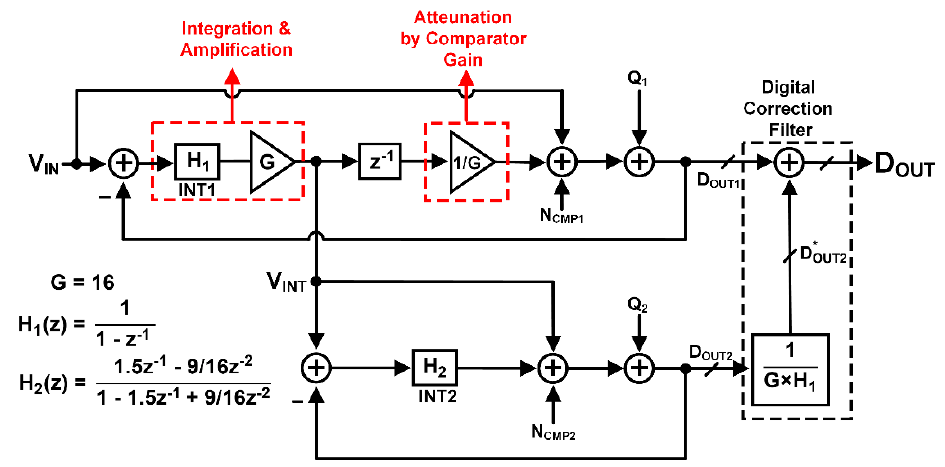
Figure 2. The pipelined noise-shaping SAR ADC block diagram.